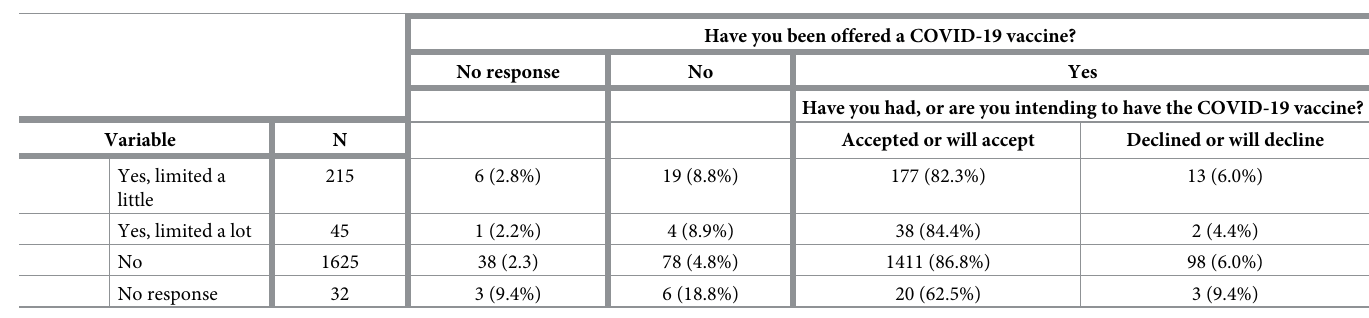
Table 5 gives coefficients and the Wald statistic, odds ratio and associated degrees of free- dom for each of the predictor variables for COVID-19 vaccination offer. Quantitative findings: Associations with declining COVID-19 vaccination 116 participants (6.6%) declined COVID-19 vaccination when offered. Among the demo- graphic variables, only ethnicity was a predictor of declining COVID-19 vaccination. After controlling for other variables in a multivariate model, Black African or Mixed Black African participants (OR: 5.550, 95%CI: 2.294–13.428) were significantly more likely to decline vacci- nation than those of White British or White Irish ethnicity. All other comparisons across eth- nicity were non-significant within the model, however, Black Caribbean or Mixed Black Caribbean was significant at the univariate level.